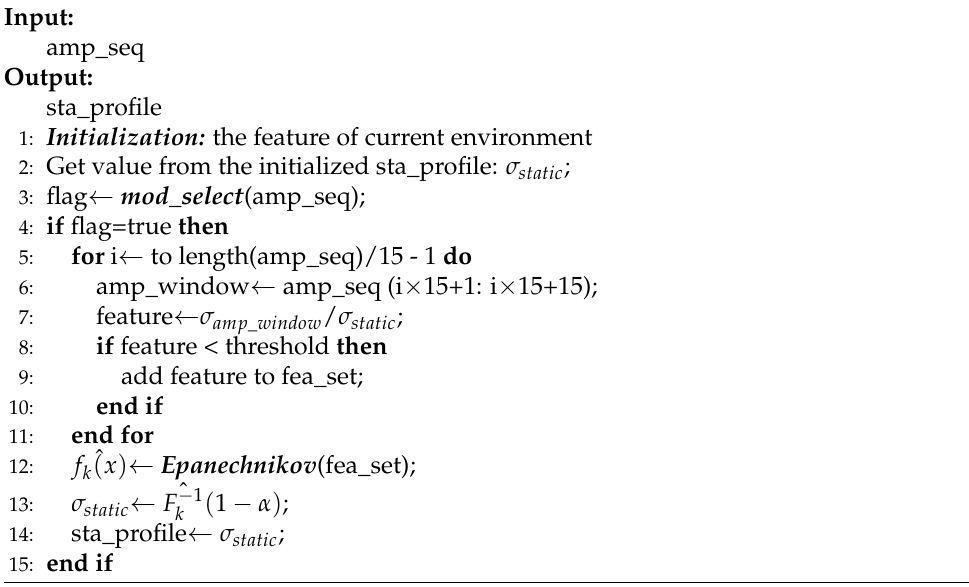
Algorithm 2 Environmental adaptive